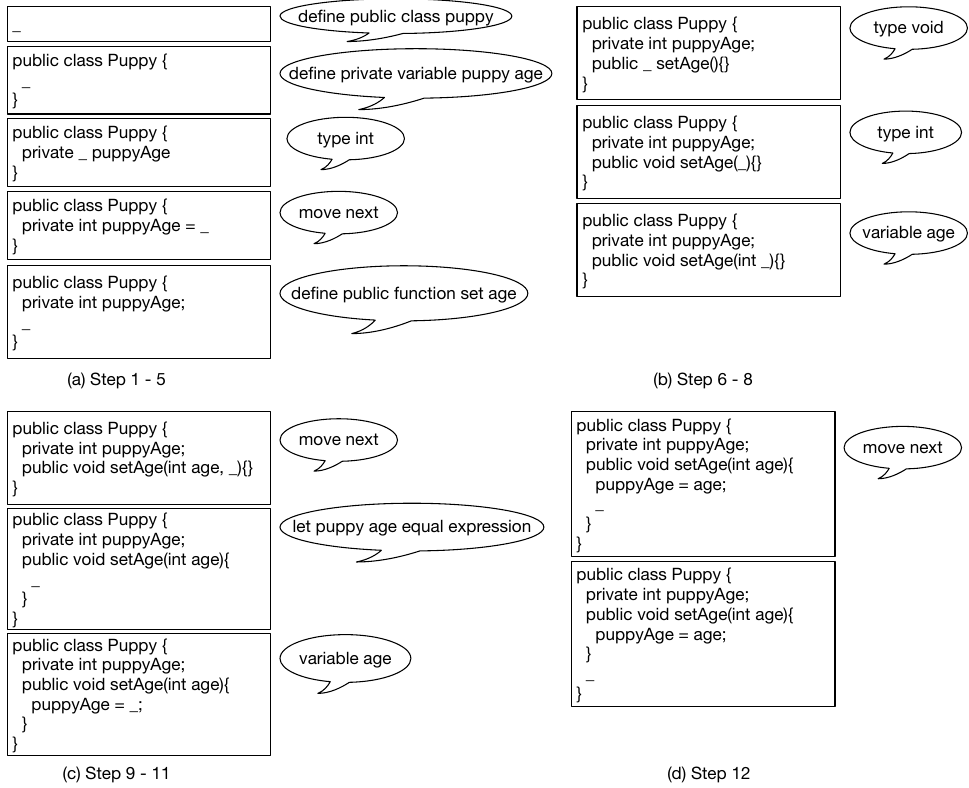
Figure 1. An example of the use of VoiceJava through syntax-directed programming. Using VoiceJava helps us dictate actual code instead of dictating plain text. Our system handles miscellaneous details, including braces, parentheses, spaces, commas, and semicolons. The programming style in VoiceJava is well-structured, so that each time, we focus on one thing instead of mixing everything. For example, we do not support defining function name, return type, and arguments in one long command [10],